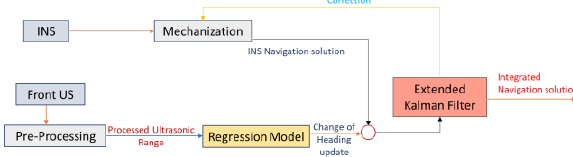
Figure 11. INS/ Front Ultrasonic integration scheme during GNSS signal outage